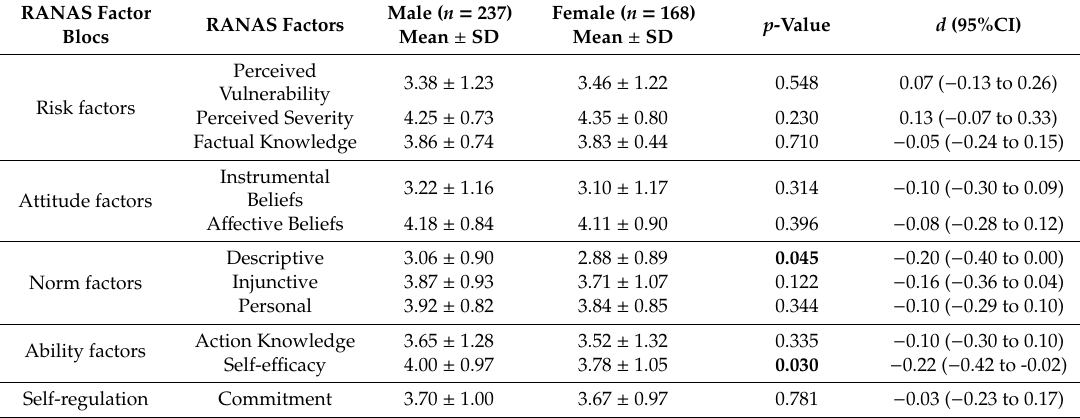
Table 3. Gender-related di ff erences within RANAS components derived from ANOVAs and quantified by Hedges’ d .